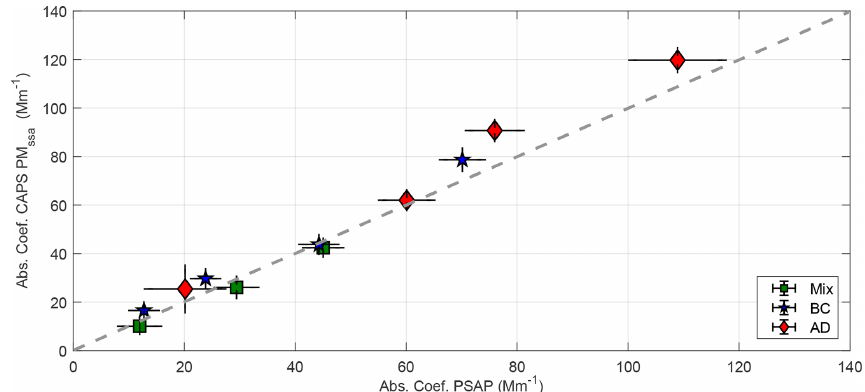
Figure 11. Comparison result (mean value and standard deviation for each level) of the absorption indirect measurement by the CAPS PM SSA with the measurements from the PSAP for AD, BC and mixture (dashed line is the identity line; i.e., 1 : 1